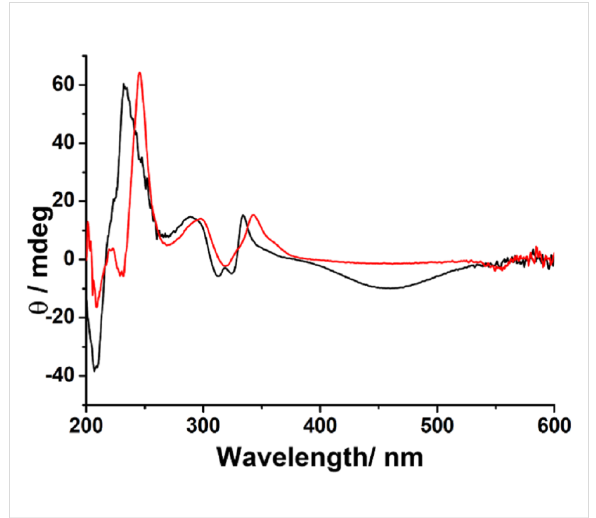
Figure 3: CD spectra recorded for solutions in THF for S -( − )-( E )- 1 (red curve) and for the reduced product of S -( − )- E - 1 , i.e., R -( − )-( E )- 2 (black